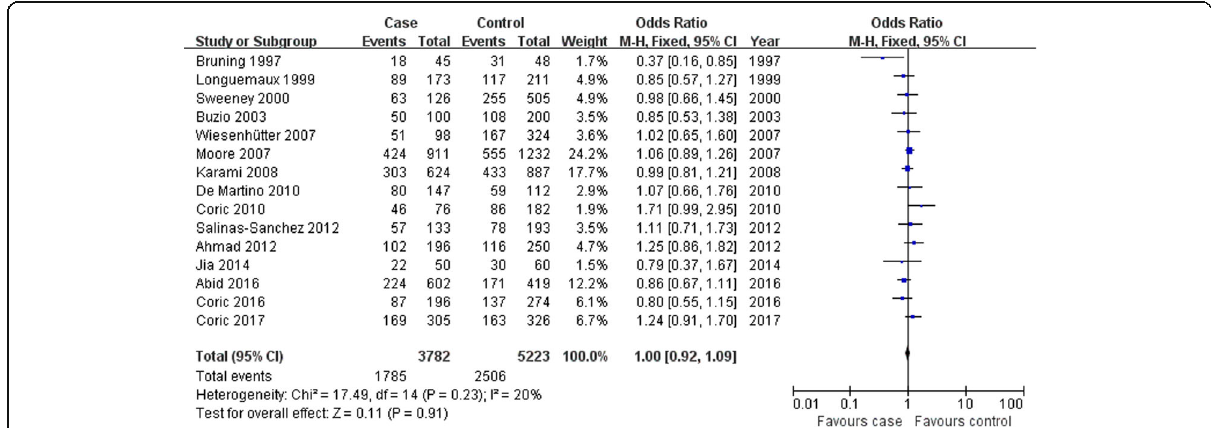
Fig. 2 Association between GSTM1 null genotype and RCC susceptibility in the overall population. CI: confidence